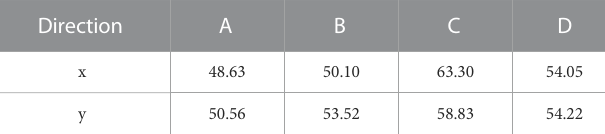
TABLE 6 Reduction of residual stress with ultrasonic power from 60 W to 240 W (%). Direction